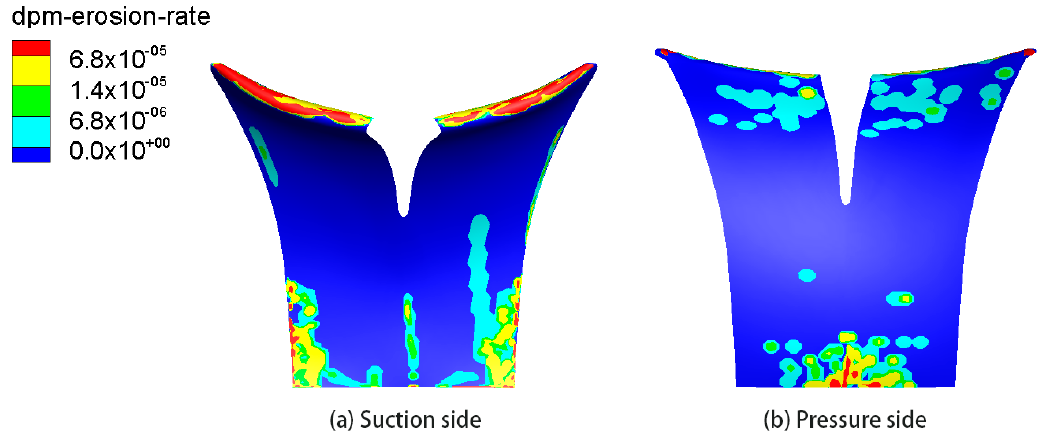
Figure 9. Silt erosion on blade surface (units: μ m/s, particle size: 0.12 mm).